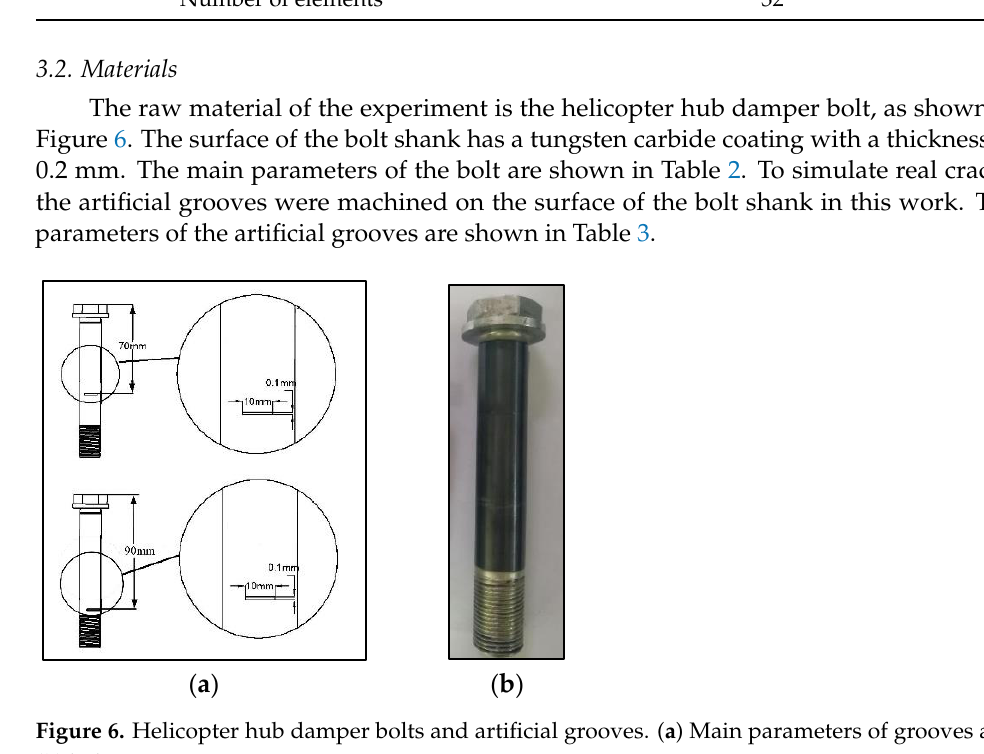
( b ) Figure 6. Helicopter hub damper bolts and artificial grooves. ( a ) Main parameters of grooves and ( b ) bolt.